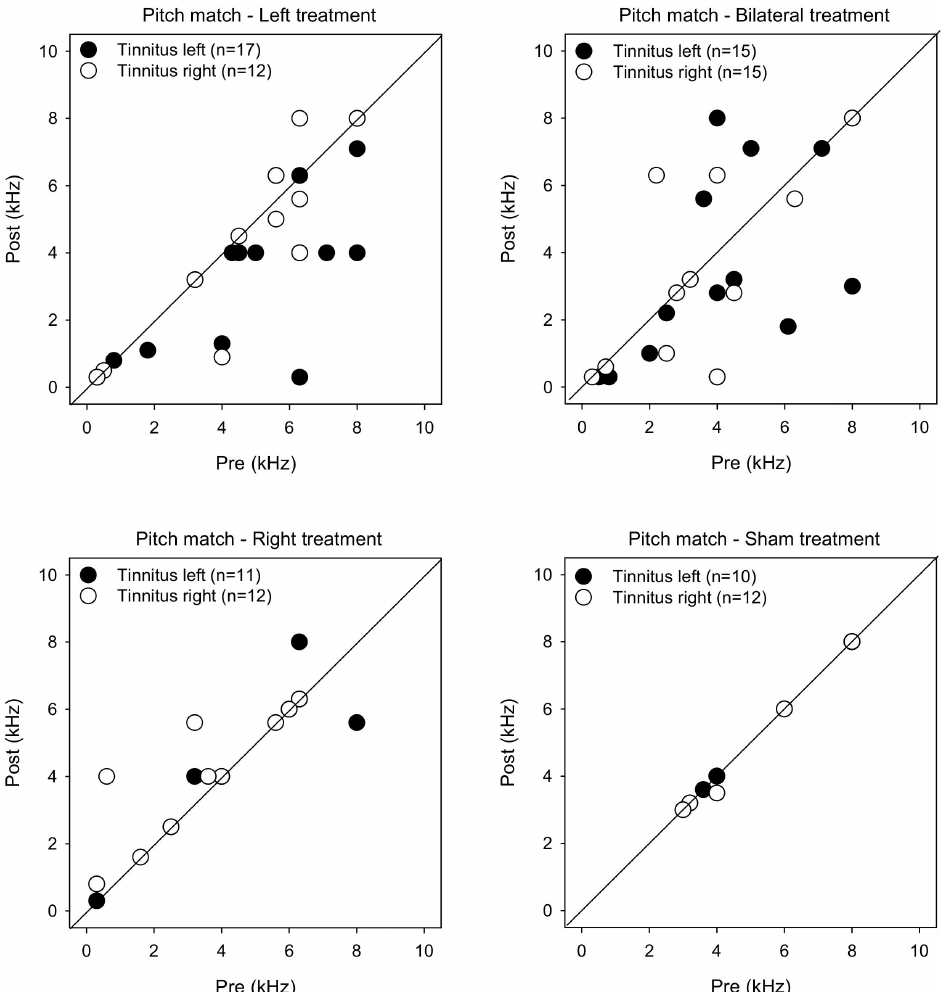
Figure 5. Post-treatment tinnitus pitch-matched frequency as a function of pre-treatment frequency for the Left, Right, Bilateral, and Sham treatment groups. The filled and open symbols show data for patients with left- or right-sided tinnitus, respectively. Values below the diagonal line indicate reduced tinnitus pitch frequency after